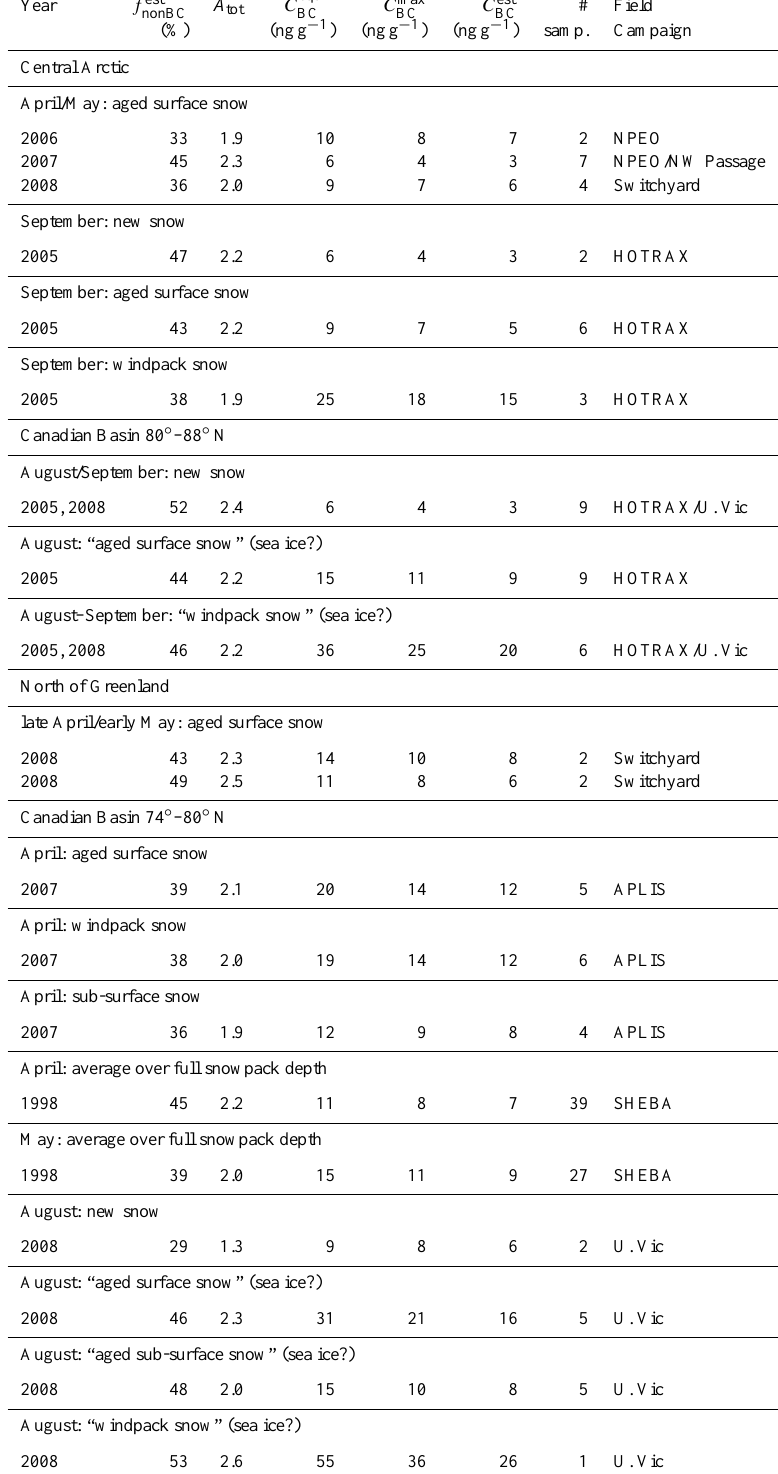
Table 3. Median values for snow samples from the Arctic Ocean, segregated by sampling region (Fig. 2), season and snow